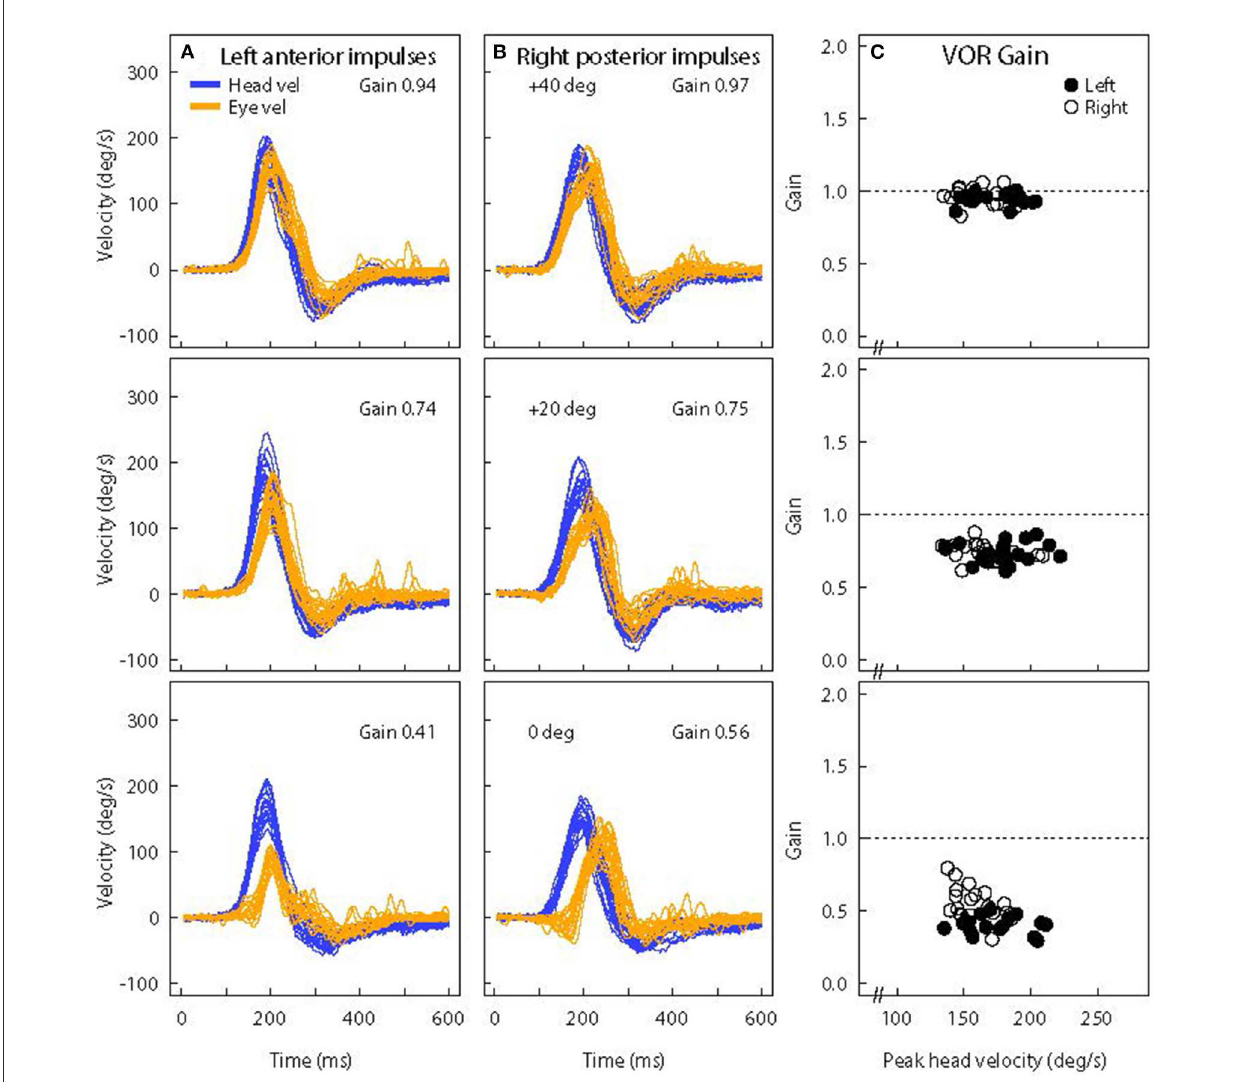
FIGURE11 Superimposed time series of eye and head velocity for a number of LARP head impulses of the same healthy subject at three horizontal gaze angles-Aligned with the LARP canal plane (40 ◦ ) (top row) and at 20 ◦ (middle row) and 0 ◦ (bottom row). The usual convention is followed-Eye velocity has been inverted to show how closely it matches head velocity. As horizontal gaze moves away from the canal LARP plane (A, B) , the measured vertical eye velocity decreases and so the VOR gain decreases (C) and at 0 ◦ it appears that the whole eye velocity response is delayed [Reproduced from McGarvie et al. (36) with permission]. The head velocity stimulus is the same in each case, but just changing gaze position reduces the measured VOR gain from around 1.0 to around 0.5. However, note that the reduced VOR gain is not corroborated by corrective saccades. The lack of corrective saccades in vertical canal testing with reduced VOR gain, is an indicator that it is incorrect gaze direction which is causing the apparent reduced VOR